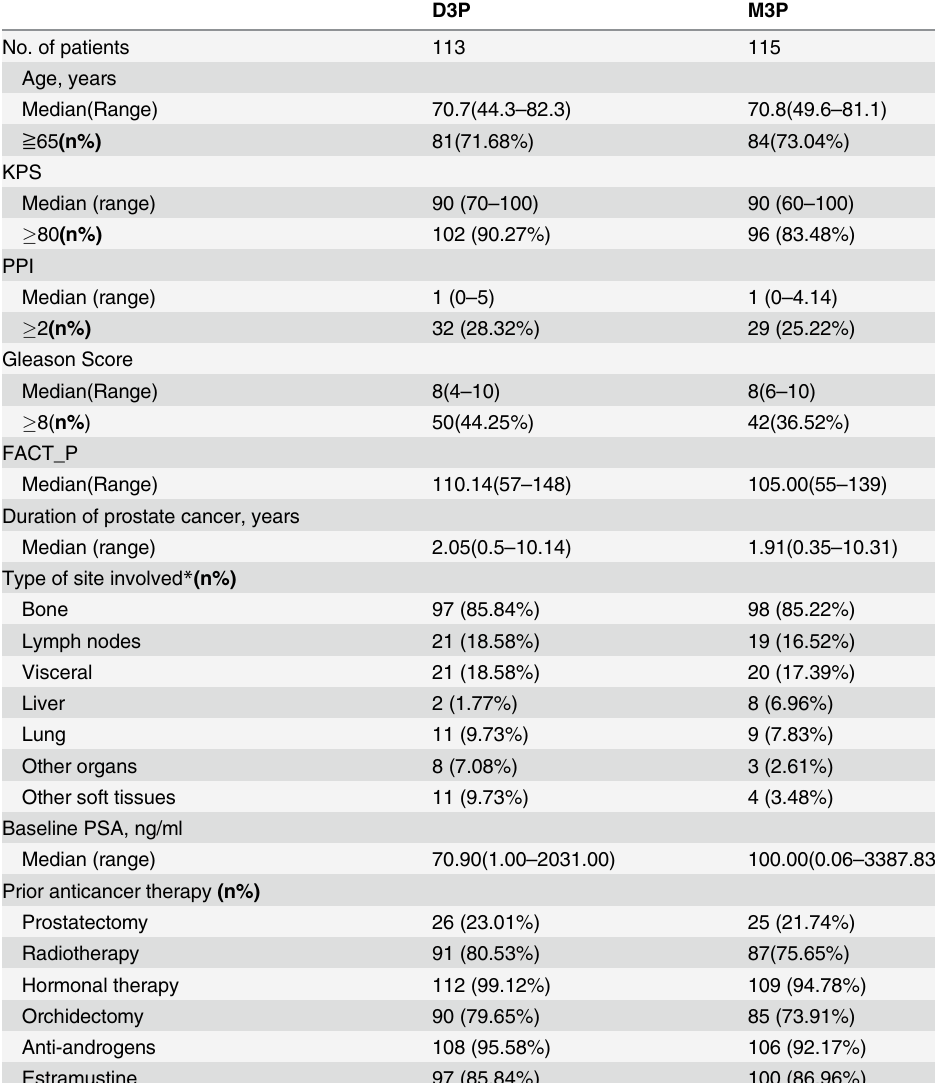
Table 1. Demographics and baseline patient